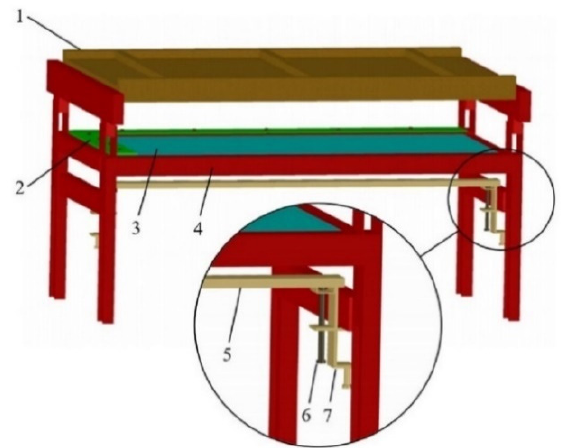
Figure 2. Test device. The symbols in the figure are as follows: ( 1 ) Reaction frame, ( 2 ) Fixed steel plates, ( 3 ) Glass, ( 4 ) Support frame, ( 5 ) Square steel pipe, ( 6 ) Screw, ( 7 ) Fixed buckle.